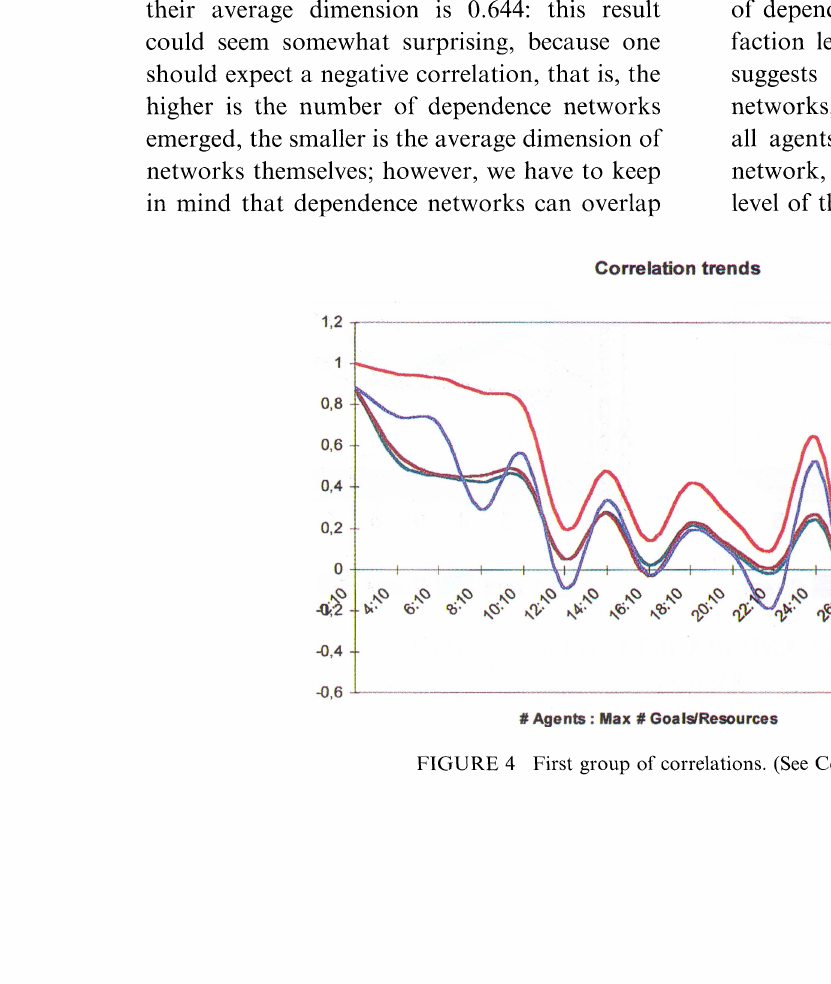
FIGURE 4 First group of correlations. (See Color Plate